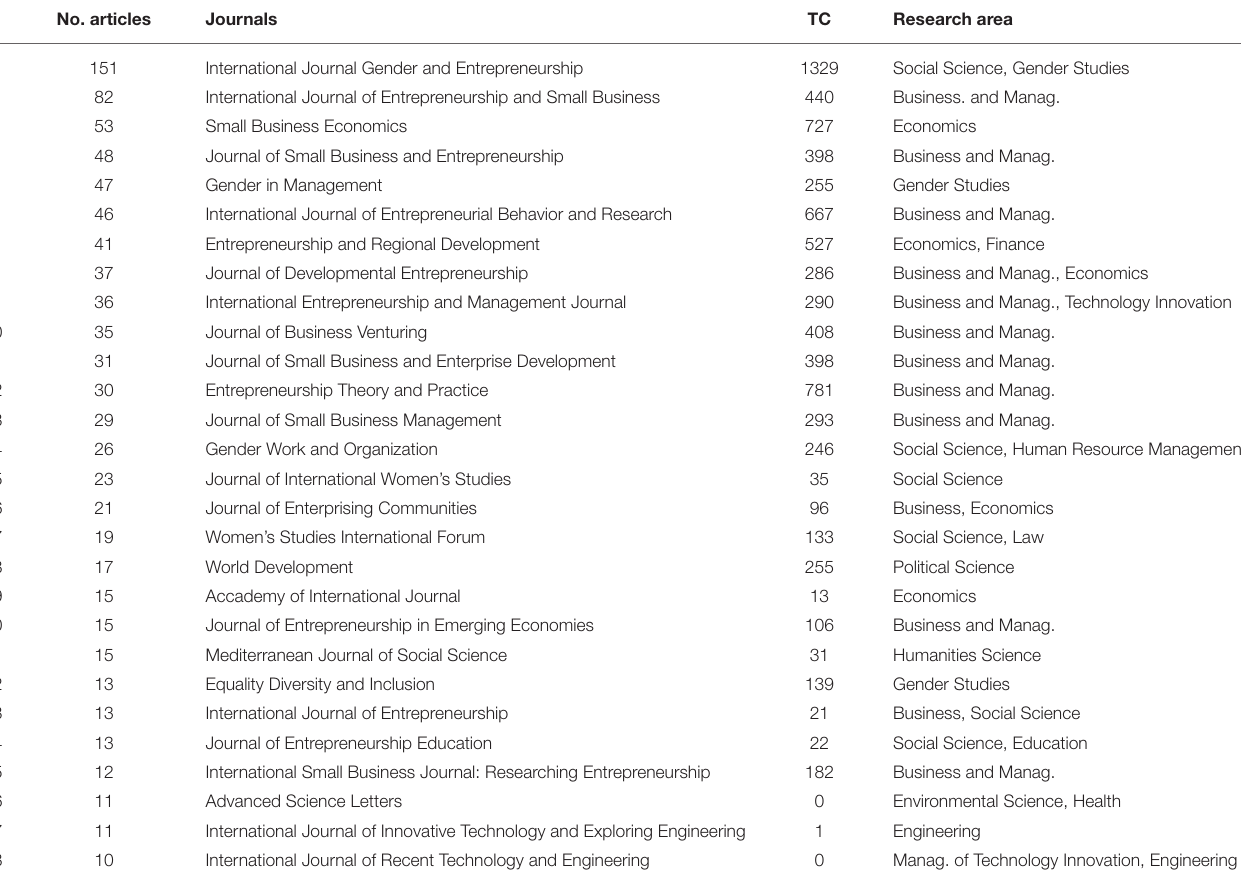
TABLE 2 | Scientific journals with the most publications on the subject and Research